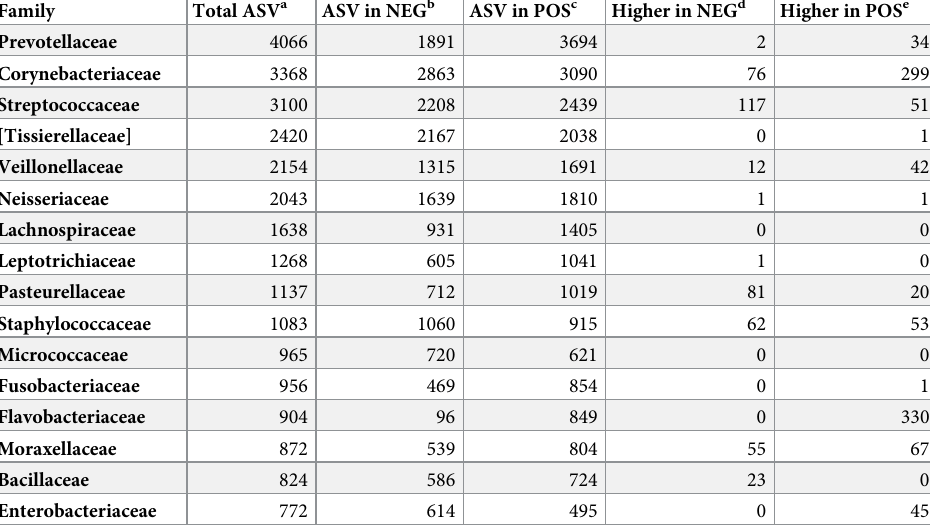
Table 5. 16S family level relative abundance.